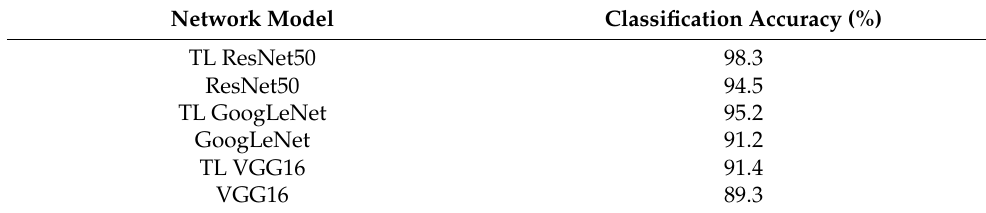
Table 1. Accuracy of several network models.